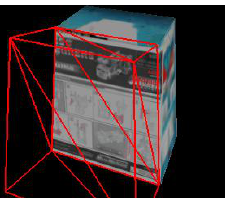
Figure 23. Lu method recovering an inverted pose.